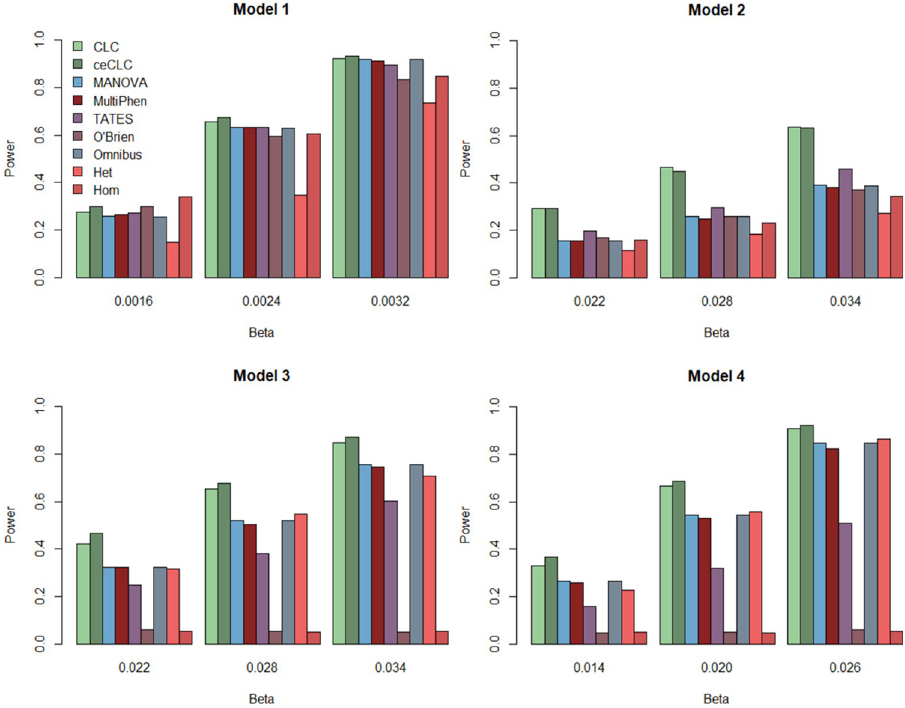
Fig 1. Power comparisons of the nine tests, CLC, ceCLC, MANOVA, MultiPhen, TATES, O’Brien, Omnibus, Het, and Hom with 20 quantitative phenotypes for the sample size of 5000.